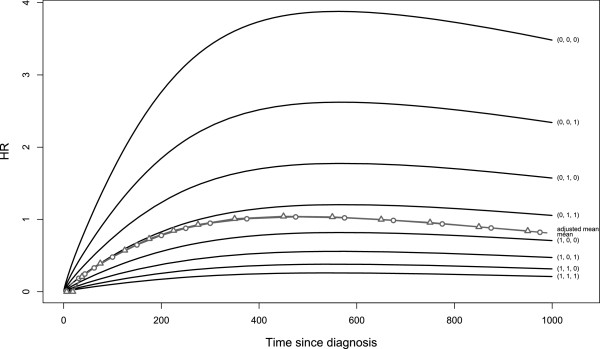
HR(t)configuration chosen. Increasing then decreasing HR(t) configuration, for each Z profile and on average, without censoring and with β12′=−0.2,−0.4,−0.8, β13=−β12 and β23=−β13. This figure displays the theoretical estimations of HR¯t called “mean”, HR¯a(t) called “adjusted mean” and HRi(t) in the eight prognostic profiles. The profile Z′=(0,0,0) at time t=0 is the profile with the better prognosis; the profile Z′=(1,1,1) has the worse prognosis, and the 6 others an intermediate prognosis. In this particular configuration chosen, where β23=−β13, HR¯t≃HR¯at and their values are so close that the difference between them is not visible in this figure.